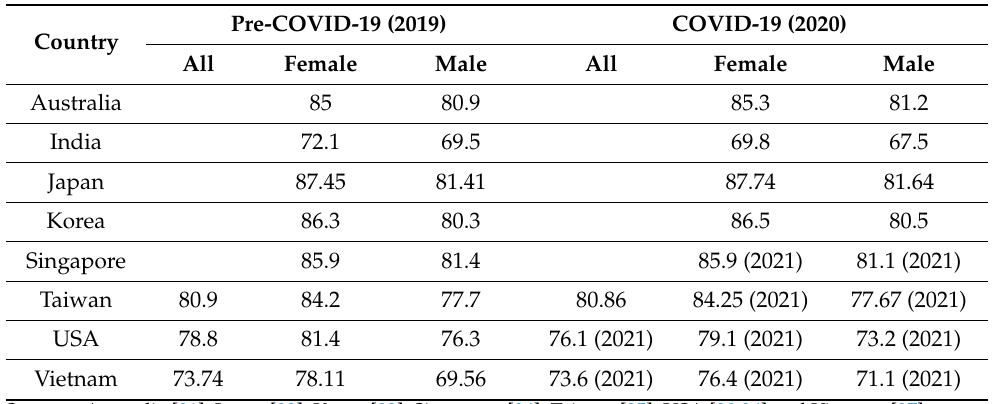
Table 3. Life Expectancy Changes in the COVID-19